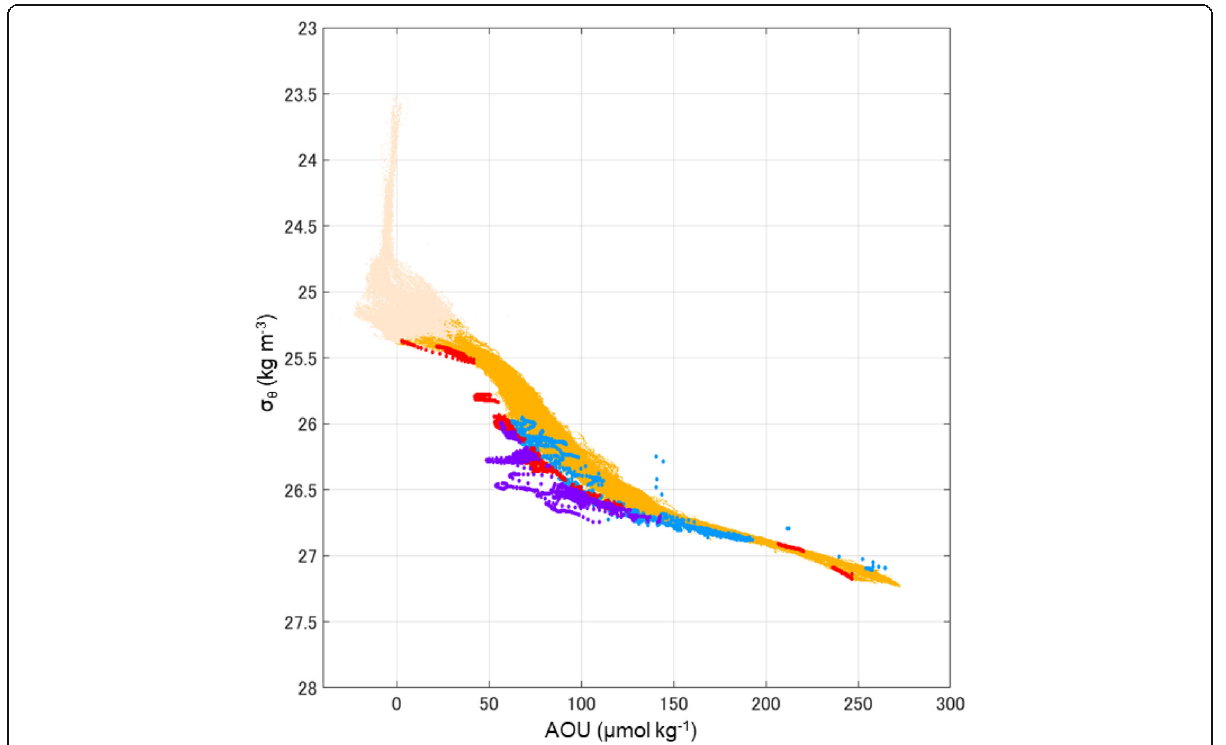
Fig. 11 Same as Figs. 9 and 10, except for σ θ -AOU diagram, colored with over 3 σ of negative salinity anomaly (blue circles), positive DO anomaly (red circles), and both (purples). AOU is calculated by Cs-DO. Light orange indicates DO measurements in the euphotic